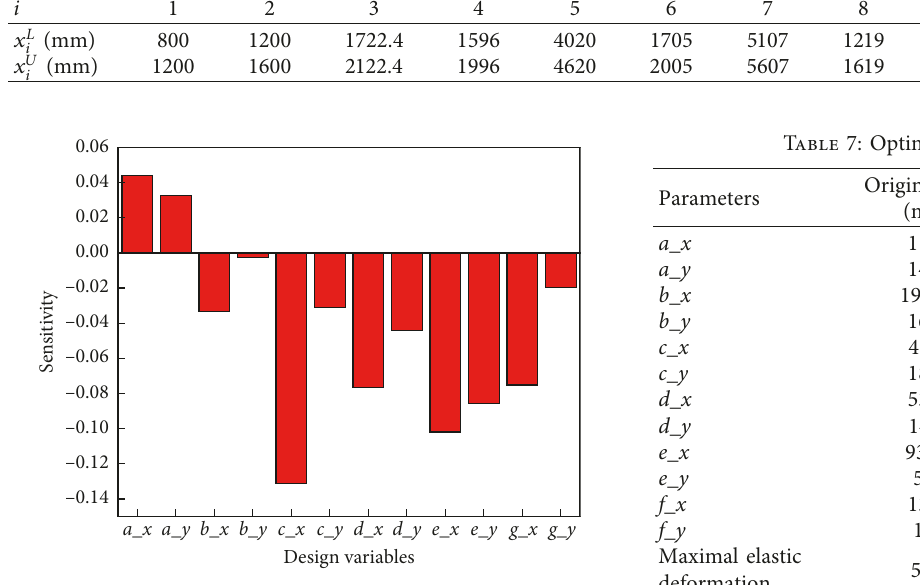
Figure 14: The sensitivity of design variables. Table 6: The genetic algorithm parameter settings.